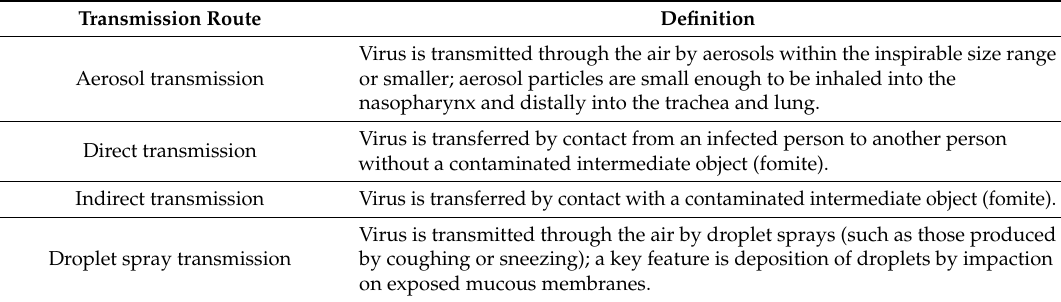
Table 1. Modes of person ‐ to ‐ person transmission of respiratory viruses [20].